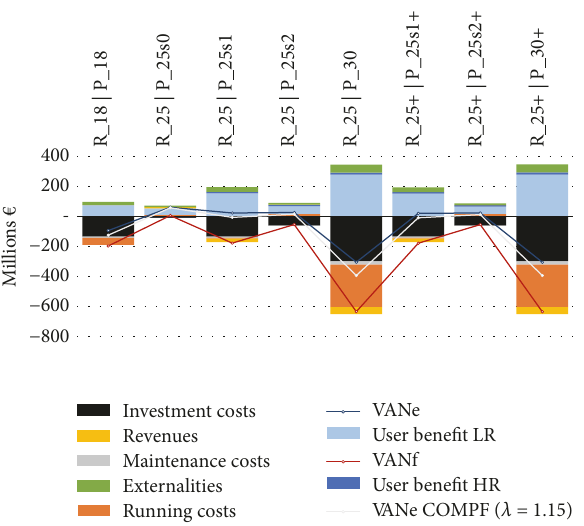
Figure 9: CBA compact indicators and costs